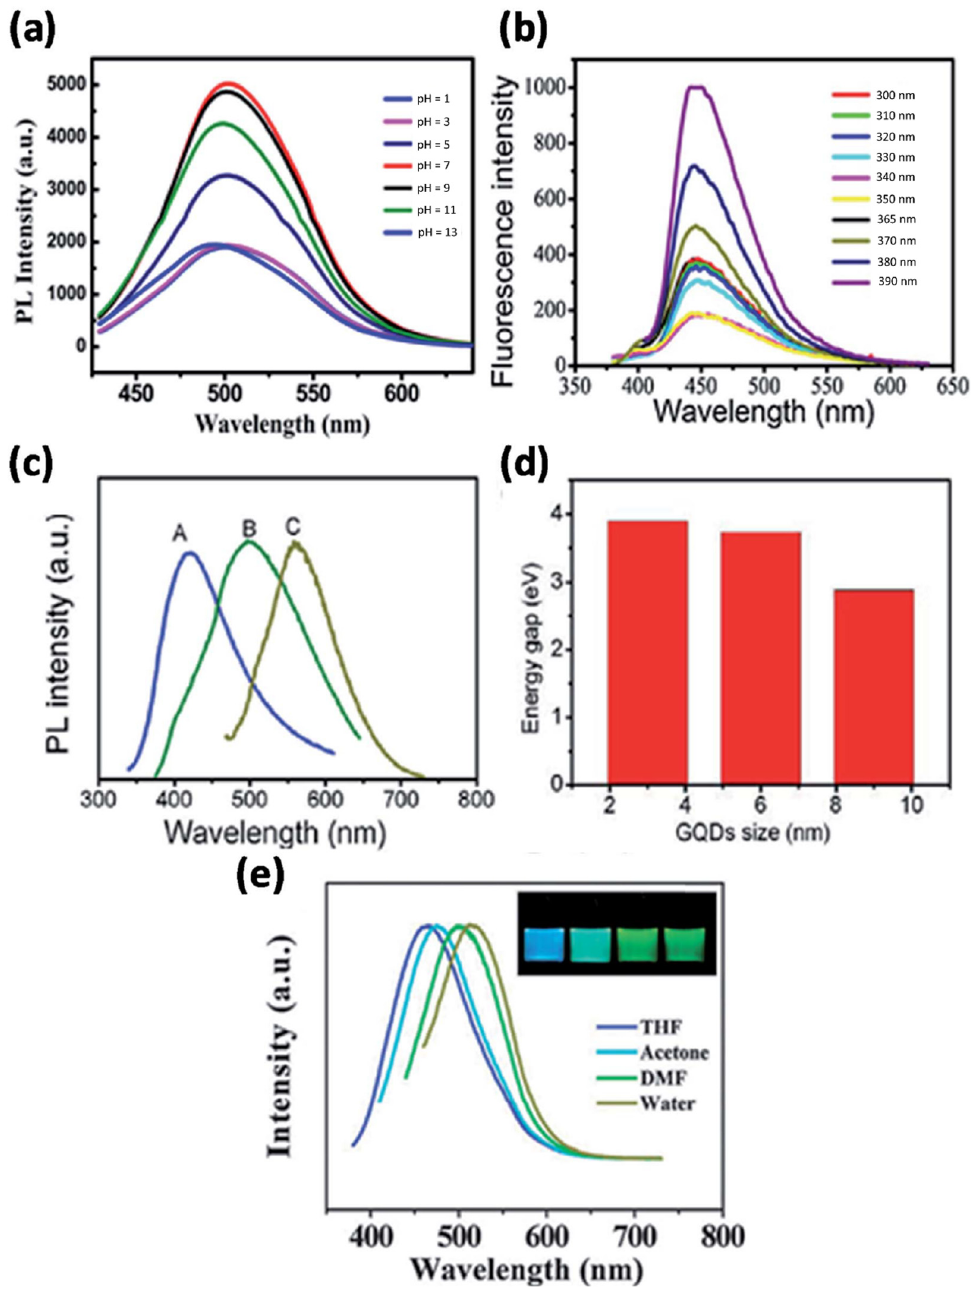
Figure 3. Fluorescence spectra of GQDs at ( a ) different pHs. ( b ) Different excitation wavelengths. ( c , d ) Different sizes of GQDs and their band gap energy. ( e ) Different solvents. (Reprinted from [8]; published by The Royal Society of Chemistry).